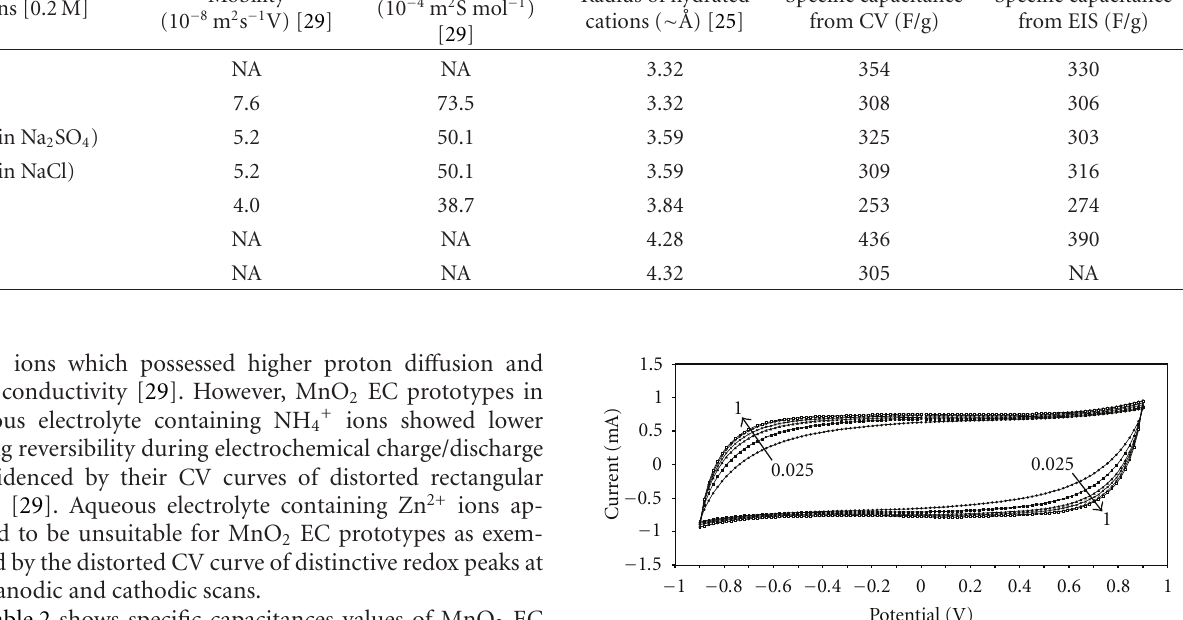
Table 2: Specific capacitance (F/g) of MnO 2 -based electrochemical capacitors in di ff erent aqueous electrolytes calculated from cyclic voltammograms (CVs) at scan rate of 50mV/s and electrochemical impedance spectroscopy (EIS) at the frequency of 10mHz. Cations [0.2M]